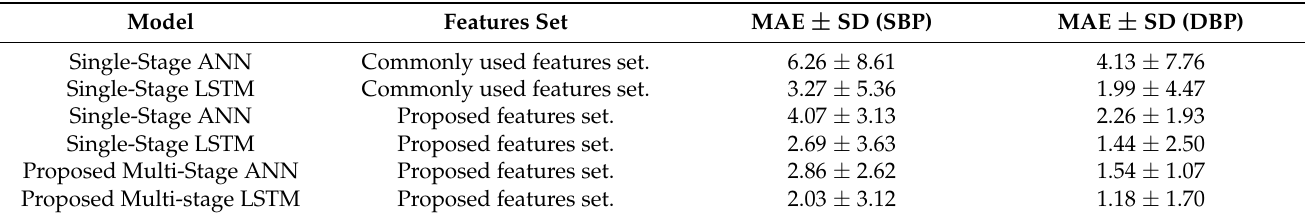
Table 8. Comparison Between Single-Stage Traditional Models and Proposed Multi-Stage Models Results. Model Features Set Single-Stage ANN Commonly used features set. Commonly used features